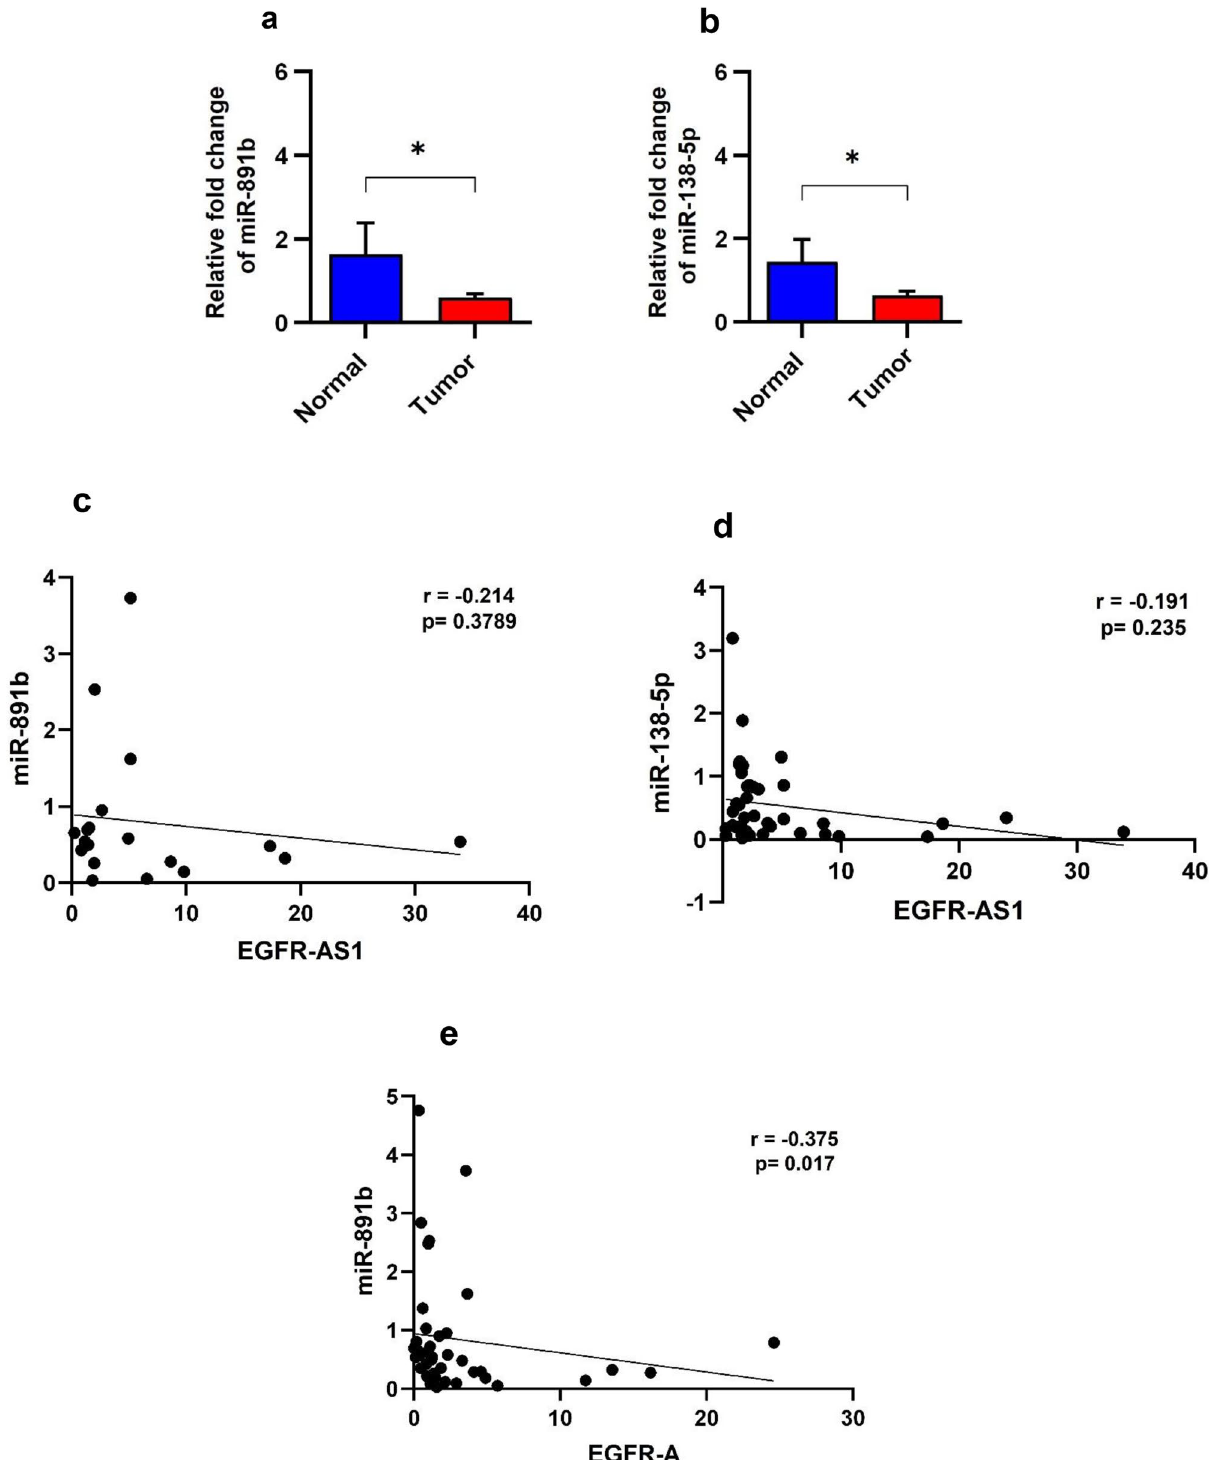
Figure 4. miR-891b sponging by EGFR-AS1 promoting the expression of EGFR-A isoform. ( a ) Graph showing the relative fold change of miR-891b. ( b ) Graph showing the relative fold change of miR-138-5p. ( c ) Scatter plot showing the correlation analysis of EGFR-AS1 in relation to miR-891b level. ( d ) Scatter plot showing the correlation analysis of EGFR-AS1 in relation to miR-138-5p level. ( e ) Scatter plot showing the correlation analysis of EGFR-AS1 in relation to miR-891b. (Statistical significance represented as * for p-value < 0.01, two tailed Student’s t-test and Spearman rank correlation